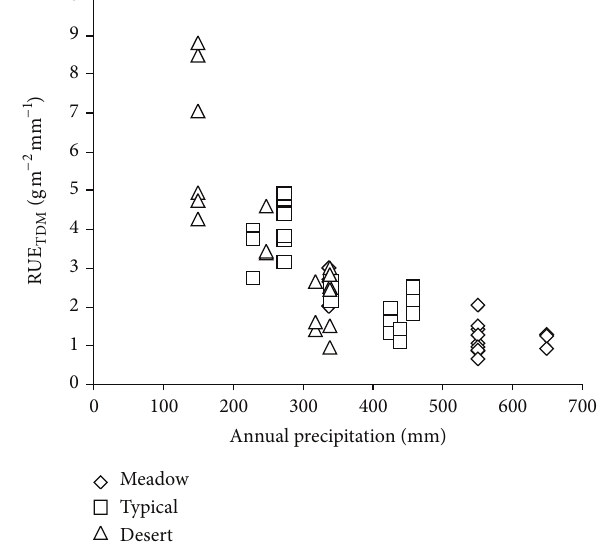
Figure 5: Relationship of RUE TDM (gm −2 mm −1 ) with annual pre- cipitation in meadow steppe, typical steppe, and desert steppe across thegrasslandofInnerMongolia.RUE TDM =rainuseefficiencybased on total dry